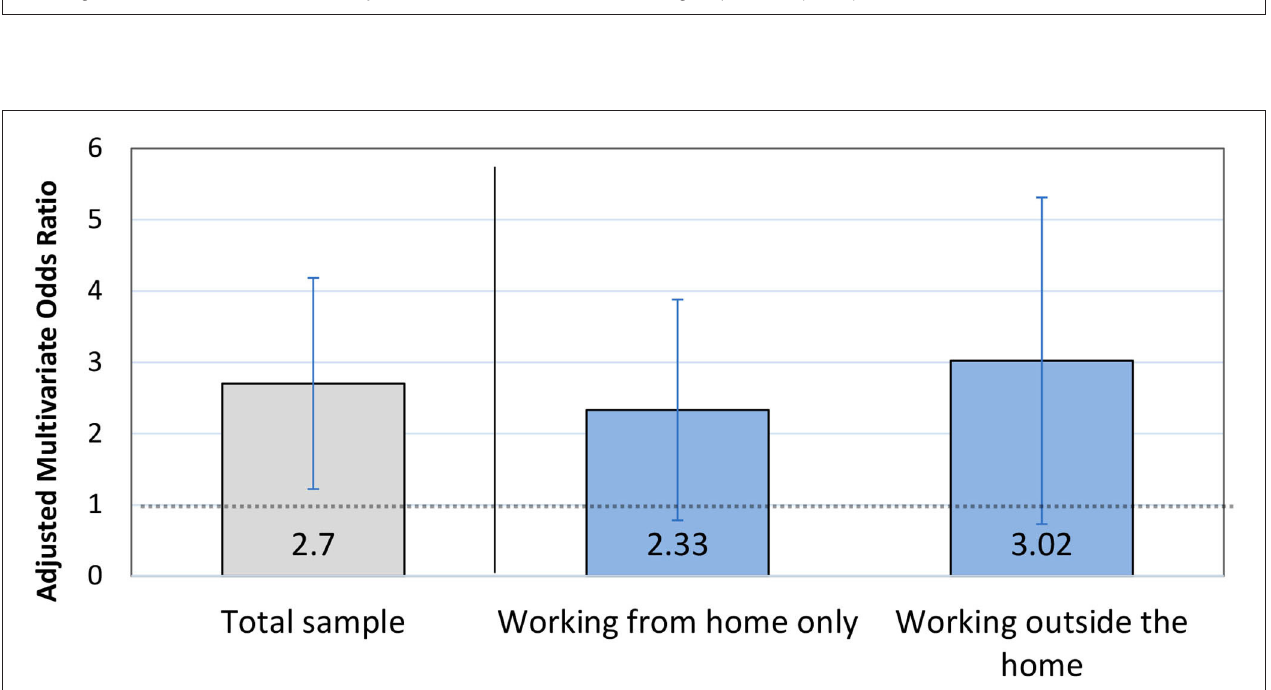
FIGURE 2 | Prenatal depression and uncertainty surrounding COVID-19-related work-plan changes. Odds ratio and 95% confidence interval from multivariate regression model predicting clinically significant depression symptoms among participants in response to being unsure about how the pandemic would affect their work-plans. Results are shown within the total sample (in gray); and then stratified according to whether individuals worked entirely from home or outside of the home during the pandemic (in blue).